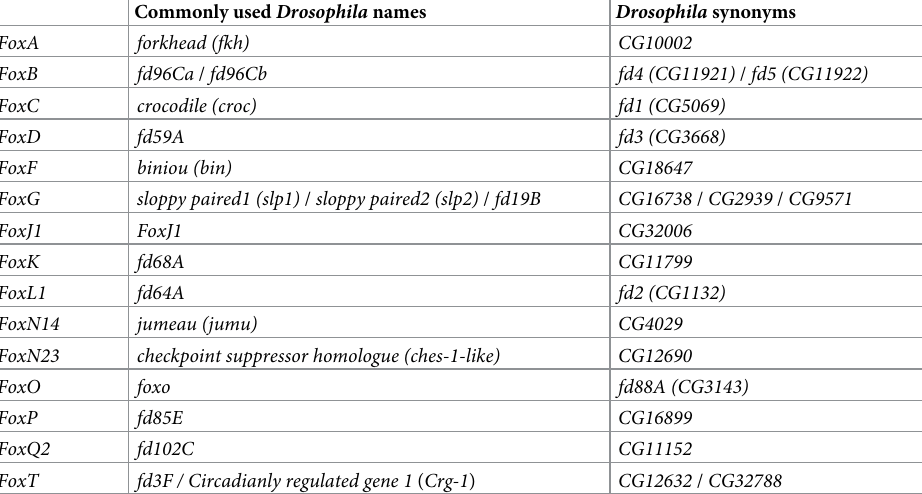
Table 1. Drosophila